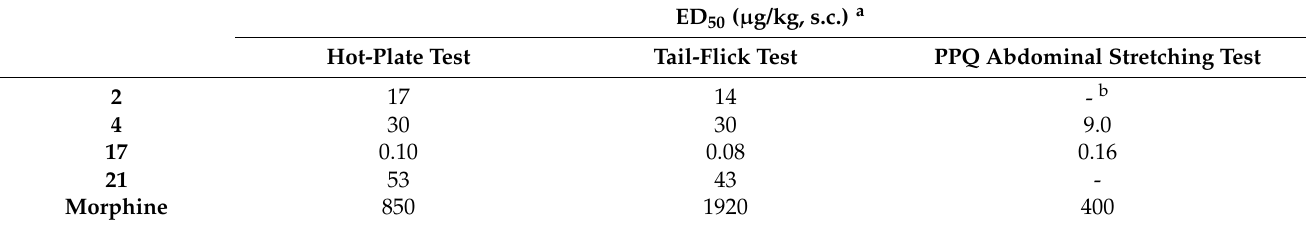
Table 7. Antinociceptive potencies of differently 5-substituted N -methylmorphinan-6-ones 2 , 4 , 17 and 21 . ED 50 ( µ g/kg, s.c.) a